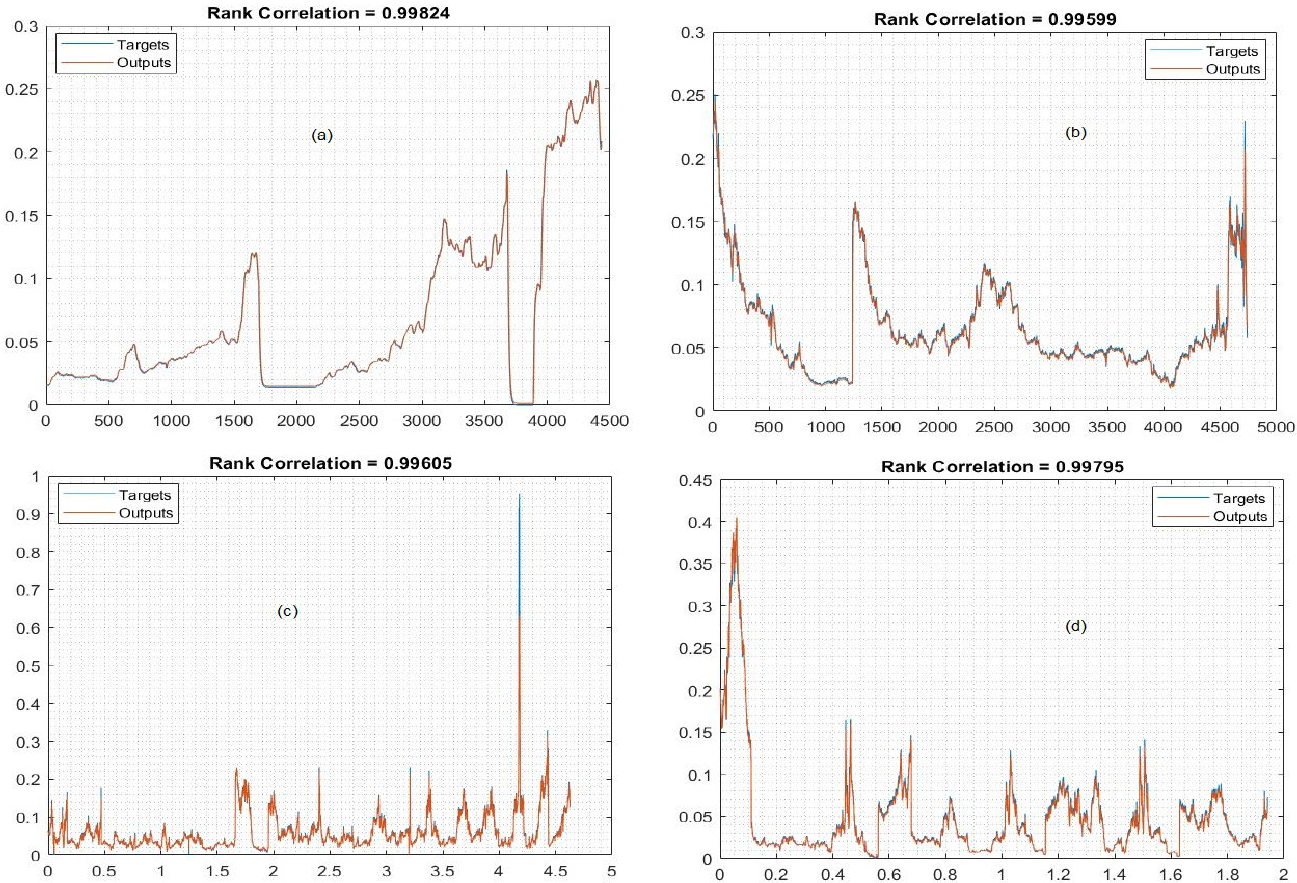
Figure 11. Prediction plot of the MLP model in the testing process, ( a ) communication ( b ) energy, ( c ) financial and ( d ) industrial sectors.